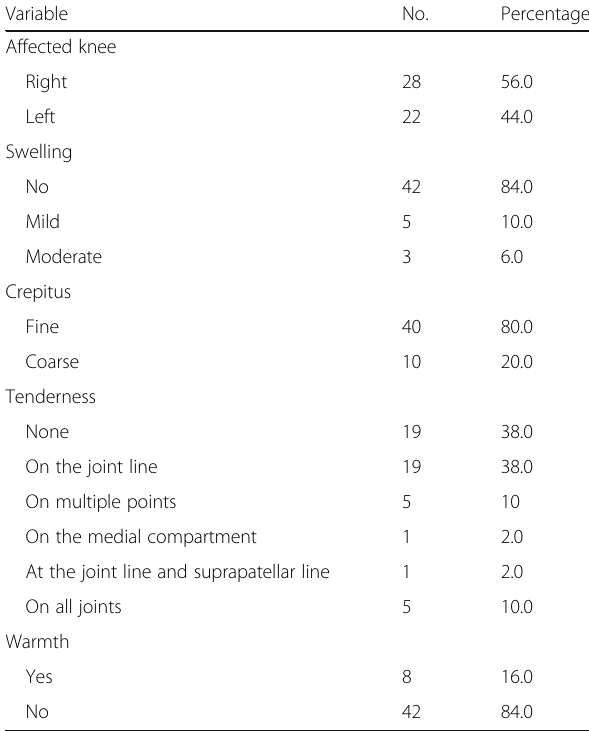
women ( r = 0.456, p = 0.011). No association between the Table 1 Demographic clinical data of 50 patients with OA